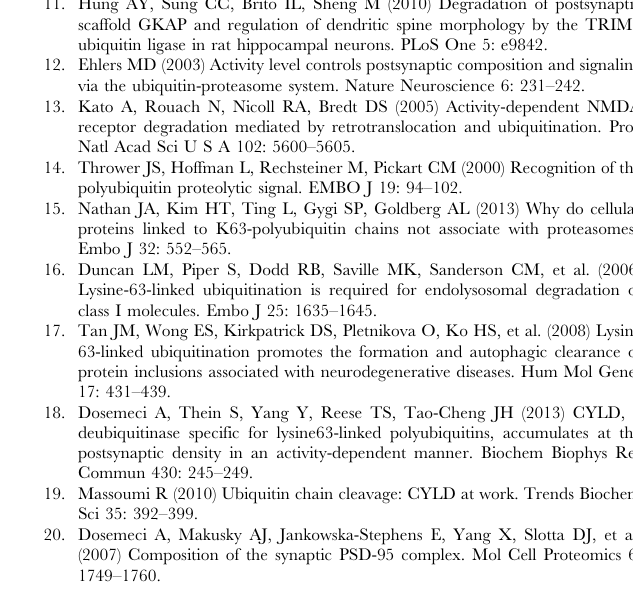
Figure S2 Phosphorylation of CYLD at S-418 assessed with a phospho-specific antibody. ( Left ) Purified CaMKII